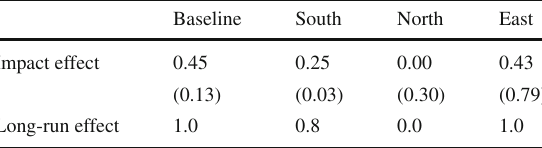
Table 3 Multiplier effect by